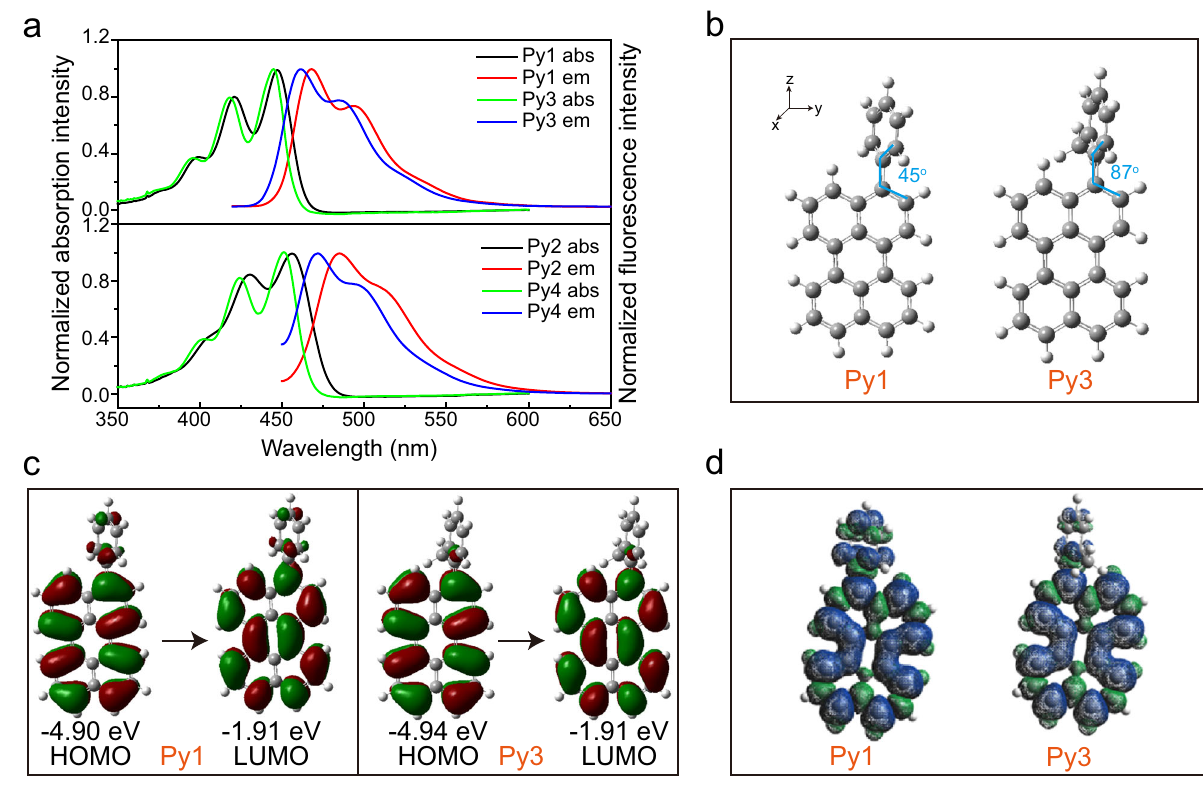
Fig. 2 | Photophysical properties and theoretical calculation of perylene deri- vatives. a Normalized UV-vis absorption (abs) and fl uorescence emission (em) spectra of Py1-Py4 in toluene. b The optimized ground state conformations of Py1